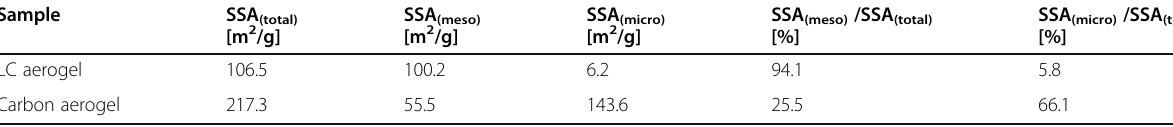
Table 1 Surface area of the LC aerogel and carbon aerogel